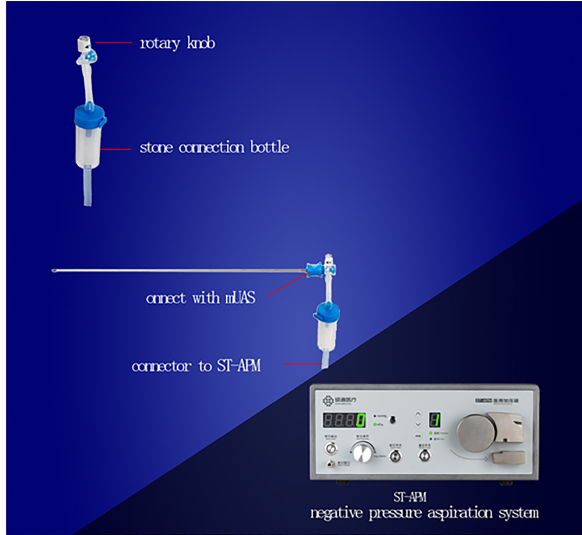
Figure 3 - Continuous negative pressure aspiration system and Lumenis Holmium laser (maximum power,